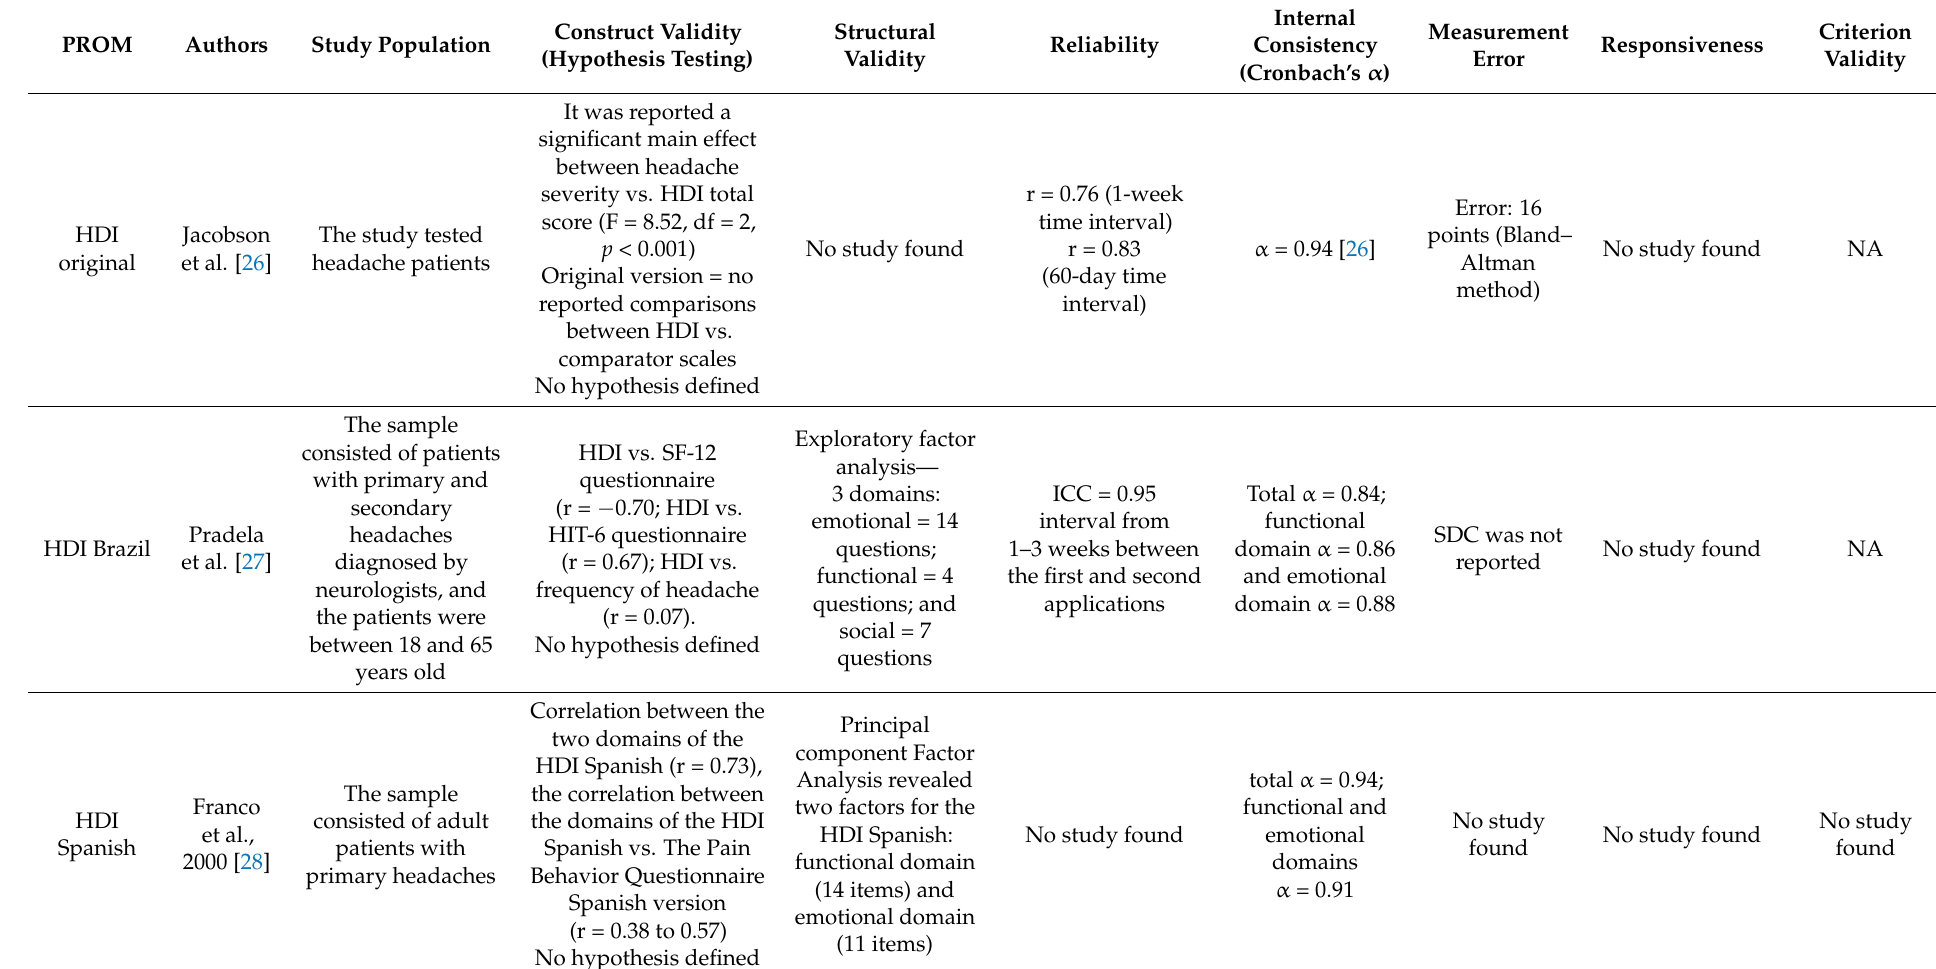
Table 5. Summary of the measurement properties of Headache Disability Inventory (HDI)